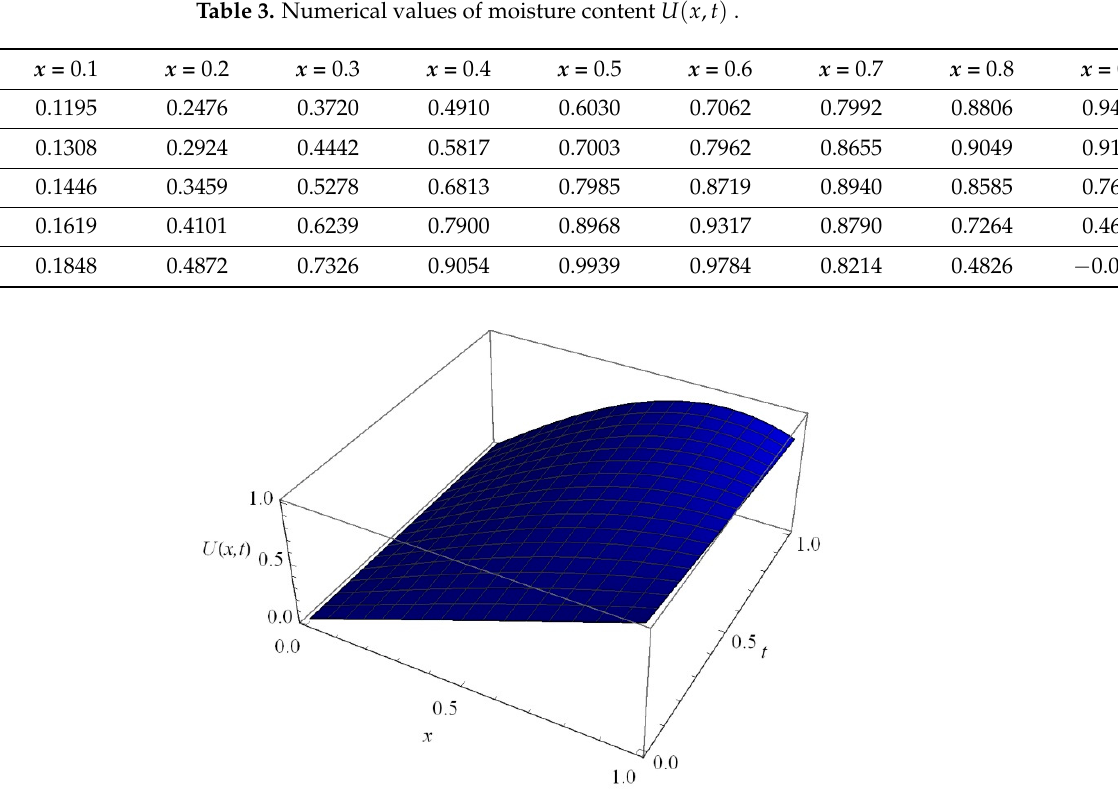
Figure 2. The graph of U ( x , t ) versus depth x and time t for Equation (29).